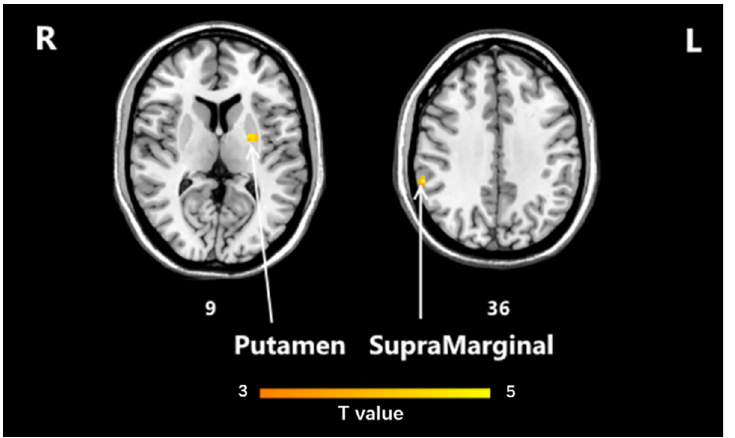
Fig 8. ReHo interaction area as the picture shows was putamen and supramarginal. ReHo, regional homogeneity.